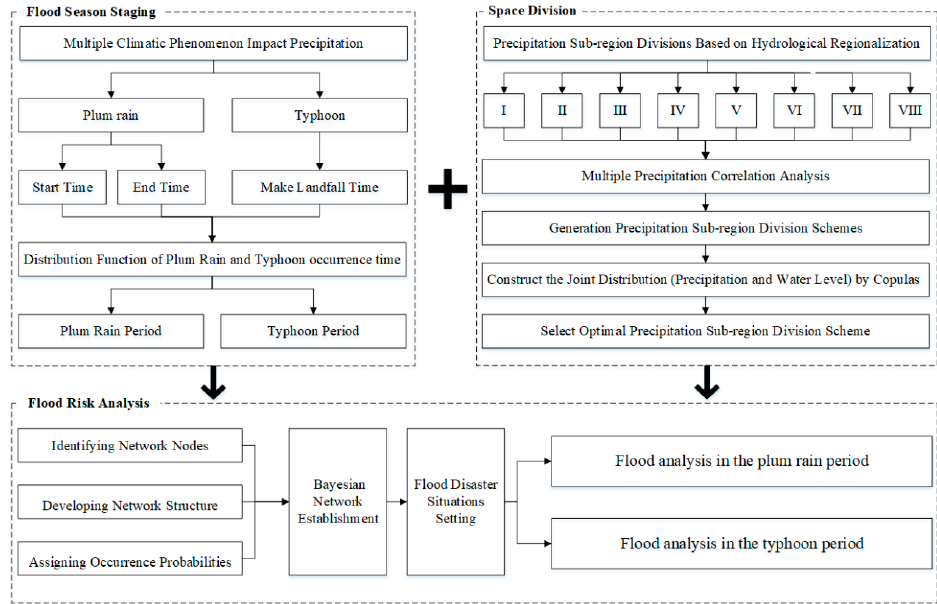
ff erent climatic